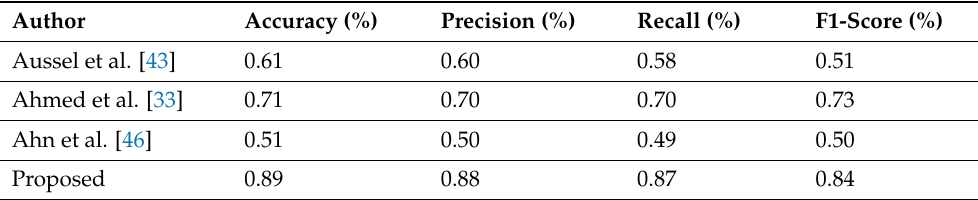
Table 9. Comparison against benchmarks in AL-based FL methods in terms of accuracy, precision, recall and